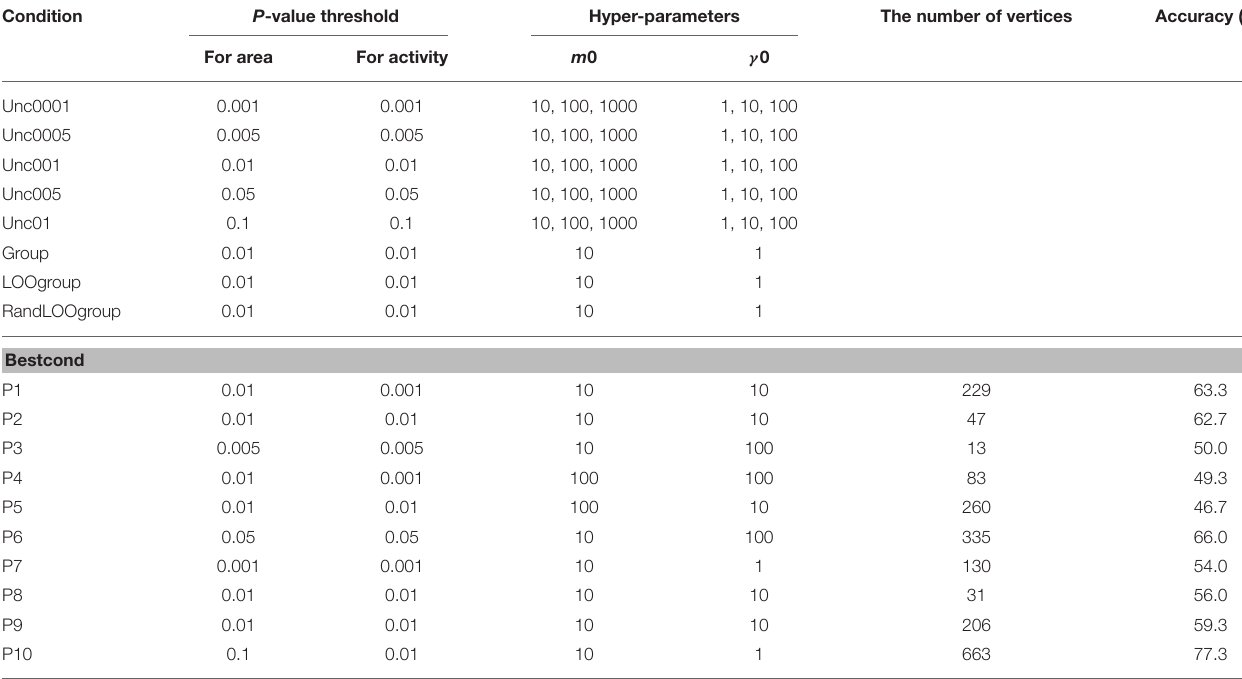
TABLE 1 | List of conditions used for designing inverse filters for EEG cortical currents. Condition P -value threshold Hyper-parameters The number of vertices Accuracy (%)